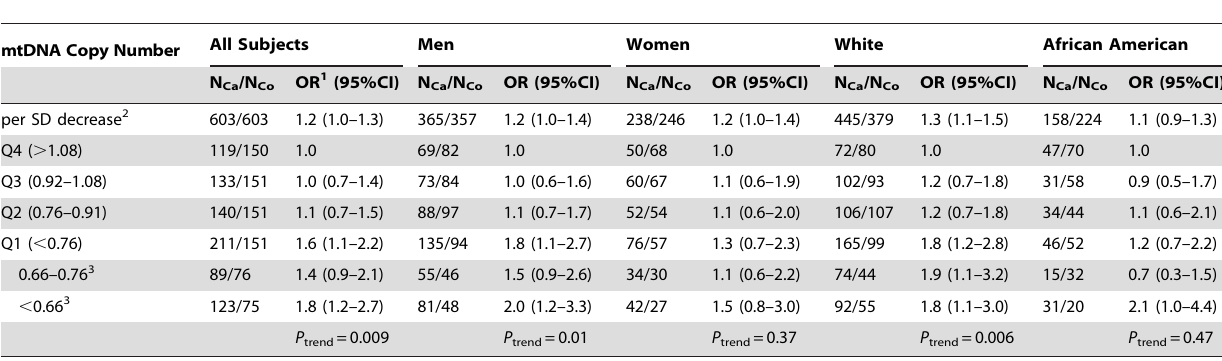
Table 2. Association between blood mitochondrial DNA (mtDNA) copy number and renal cell carcinoma risk (overall and stratified by sex and race) in the Kidney Cancer Study, 2002–2007.